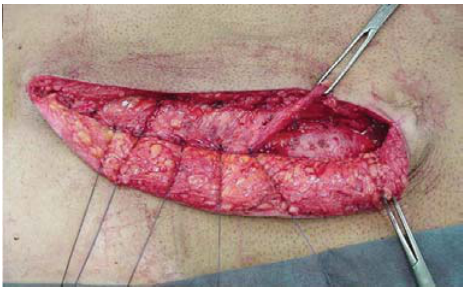
Figure 3 - U-shape stitches allowing the overlapping of the borders of the incision